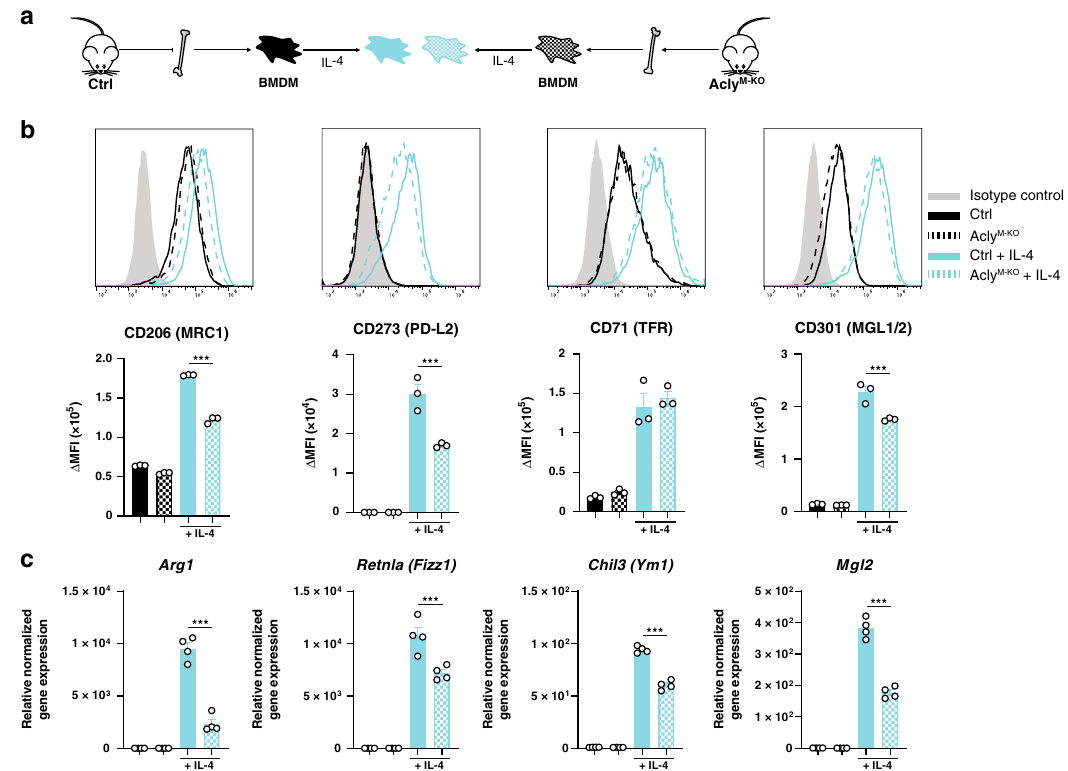
Fig. 4 IL-4 response is decreased after Acly deletion in macrophages. a Differentiated control and Acly M-KO macrophages (BMDMs) were stimulated with IL-4. b Expression of IL-4-induced surface markers as measured by fl ow cytometry. Representative histograms and quanti fi ed surface expression ( Δ MFI = [median fl uorescence intensity] positive staining – [MFI] pooled control ) are shown. CD206 *** P < 0.0001, CD273 *** P = 0.0003, CD301 *** P = 0.0008. c Relative normalized gene expression of IL-4-induced genes. Arg1 *** P < 0.0001, Retnla *** P = 0.0004, Ym1 *** P < 0.0001. Values represent mean ± SEM of n = 3 b or n = 4 c technical replicates of one out of three representative experiments. *** P < 0.001 by ordinary one-way ANOVA with Bonferroni post hoc test for multiple comparisons ( b , c ). Source data are provided as a Source Data fi le ( b , c